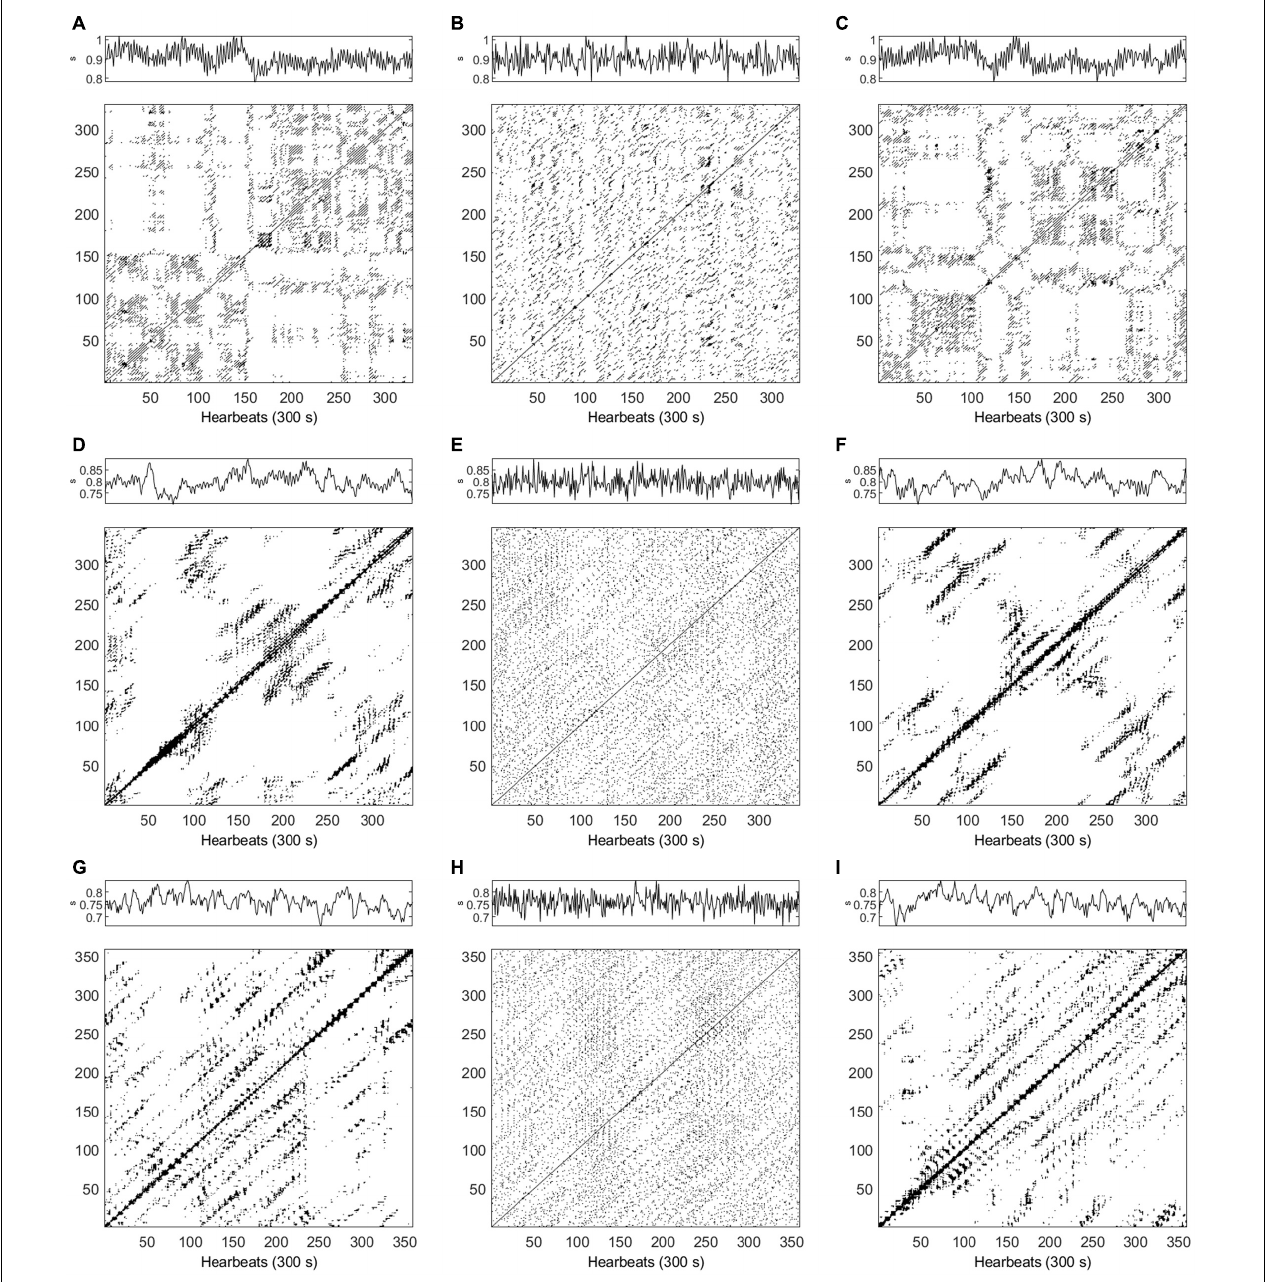
FIGURE 6 | (A–I) Examples of time series and recurrence plots for heart rate variability (HRV) data in supine position. Top row corresponds to a healthy subject ( m = 4, τ = 1), (A) original data, (B) Iterative Amplitude Adjusted Fourier Transform (IAAFT) surrogate, and (C) Pinned Wavelet Iterative Amplitude Adjusted Fourier Transform (PWIAAFT) surrogate. Middle row, end stage renal disease (ESRD) patient before hemodialysis (HD) ( m = 6, τ = 6), (D) original data, (E) IAAFT surrogate, and (F) PWIAAFT surrogate. Bottom row, ESRD patient after HD ( m = 6, τ = 7), (G) original data, (H) IAAFT surrogate, and (I) PWIAAFT surrogate. HRV time series units in all panels are shown as seconds